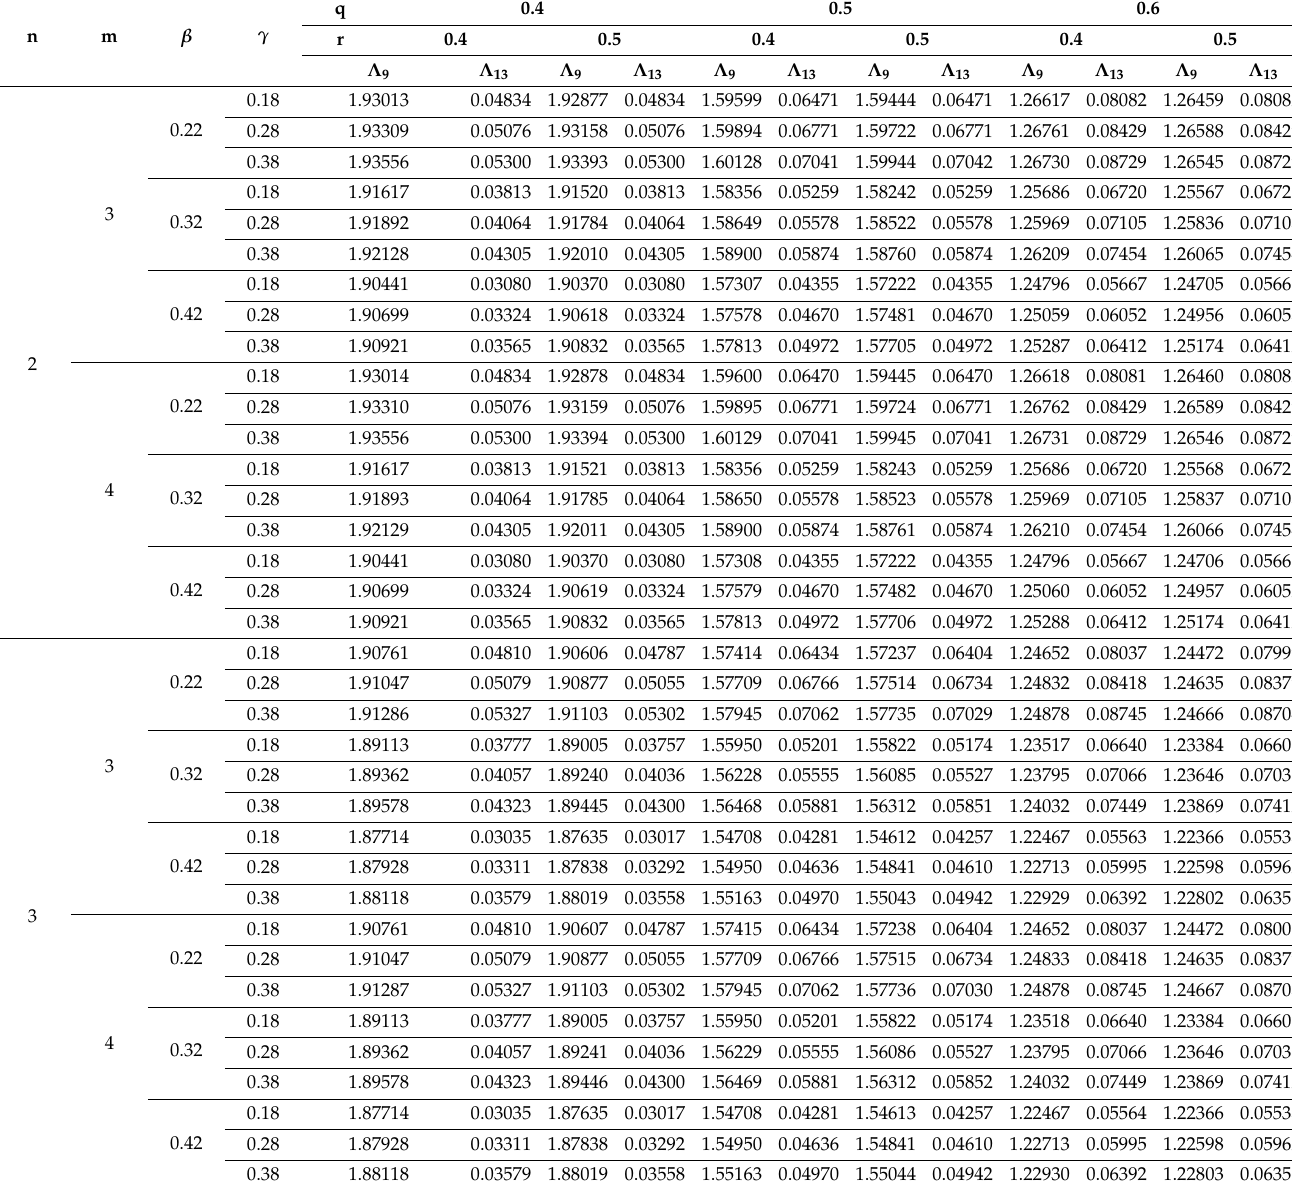
Table 8. Customer lost for combination of n , m , β , γ and q , r